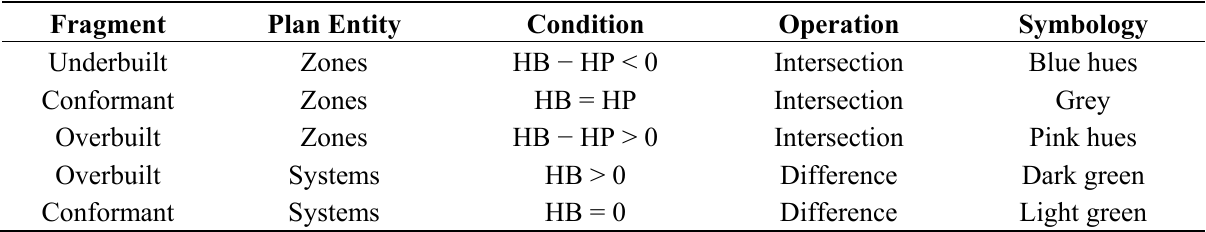
Table 1. Types of fragments from the overlay